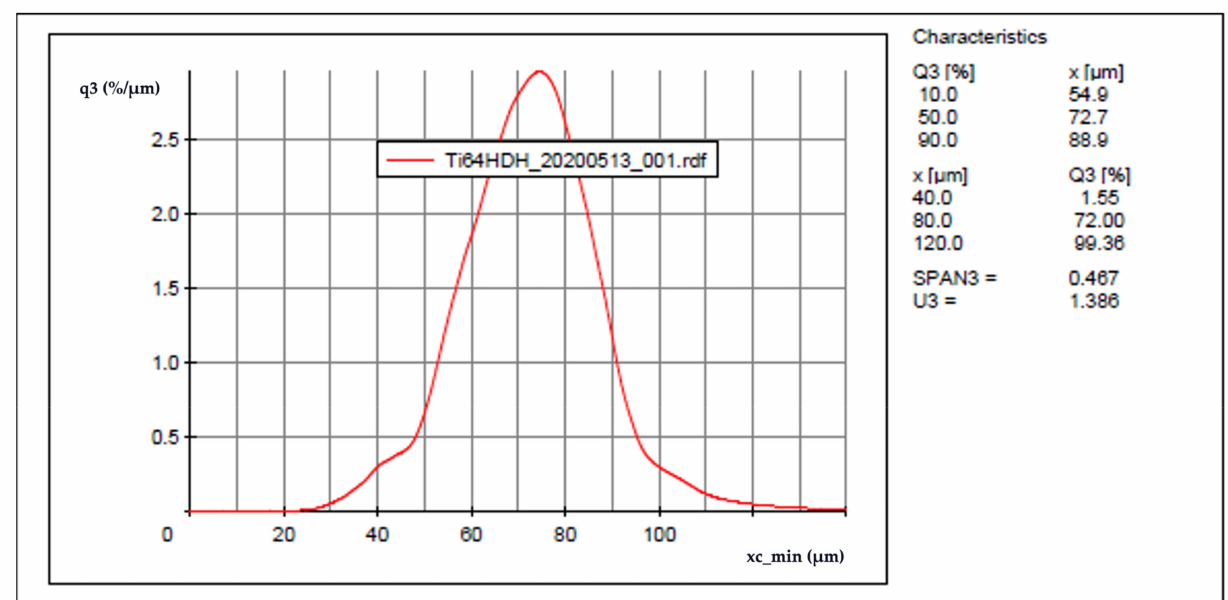
Figure 1. Particle size